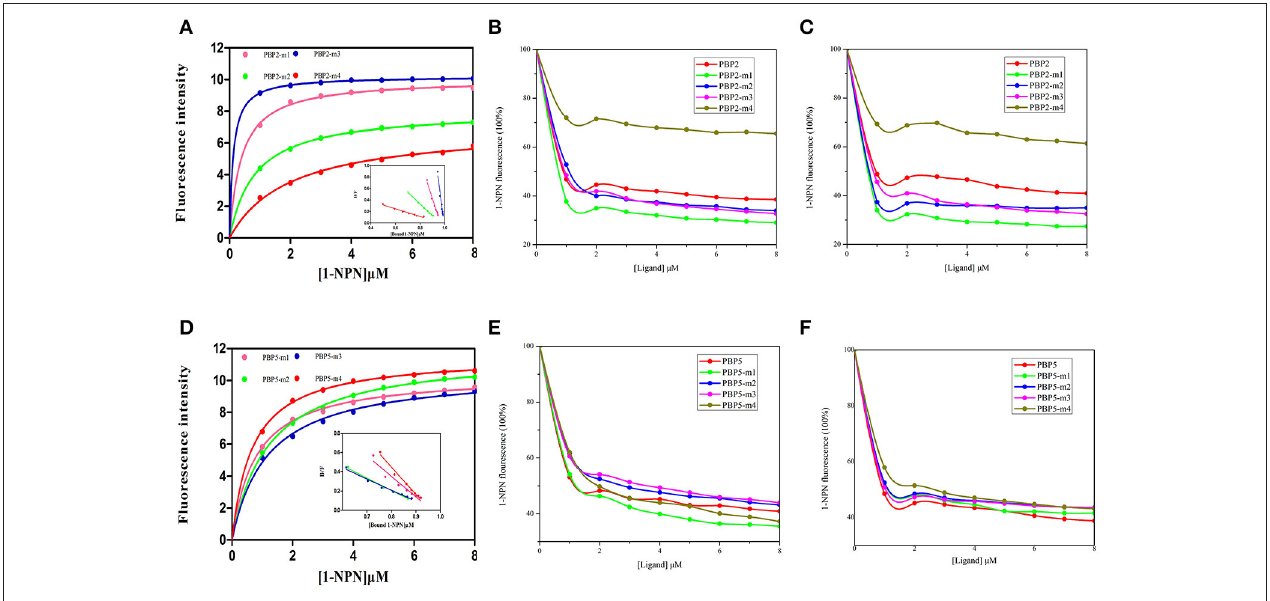
FIGURE 6 | Binding of 1-NPN and ligands to CpunPBP2 and CpunPBP5 mutants. (A) The binding curve and relative Scatchard plots of CpunPBP2 and mutants. (B) Competitive binding curves of CpunPBP2 and mutants to E 10-16:Ald. (C) Competitive binding curves of CpunPBP2 and mutants to Z 10-16:Ald. (D) The binding curve and relative Scatchard plots of CpunPBP5 and mutants. (E) Competitive binding curves of CpunPBP5 and mutants to E 10-16:Ald. (F) Competitive binding curves of CpunPBP5 and mutants to Z 10-16:Ald.